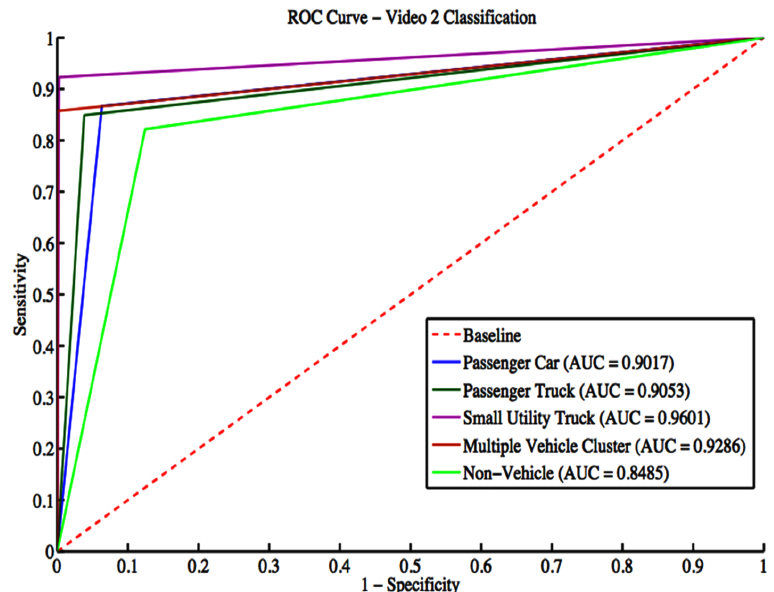
Figure 12. ROC curves for Video 2 classification. Table 10. Confusion matrix for all vehicles in Video 2.